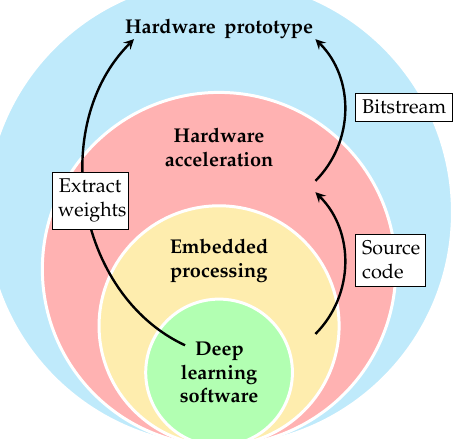
Figure 1. Methodology global view around embedded Deep Learning